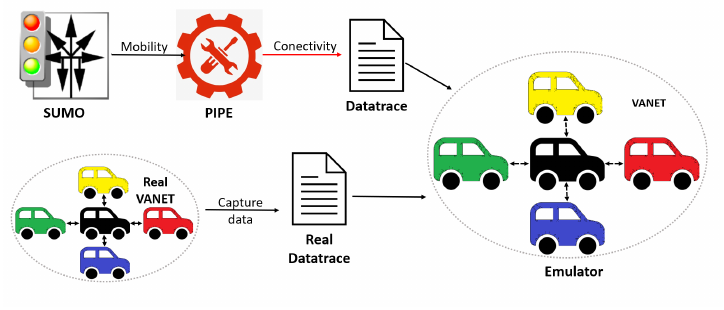
Figure 2. Tools of the emulation